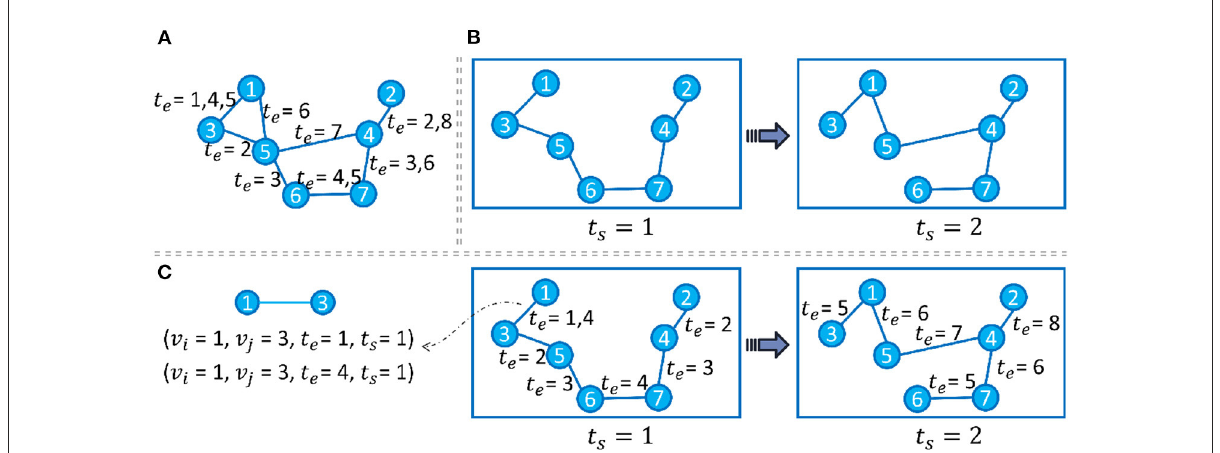
FIGURE3 Panel (A) shows a streaming graph with only edge timestamps t e . Panel (B) shows a snapshot-modeled graph with only snapshot timestamps t s , where each t s elapses every 4 t e . Panel (C) shows our multi-time evolution modeling with edge timestamps t s and snapshot timestamps t e .